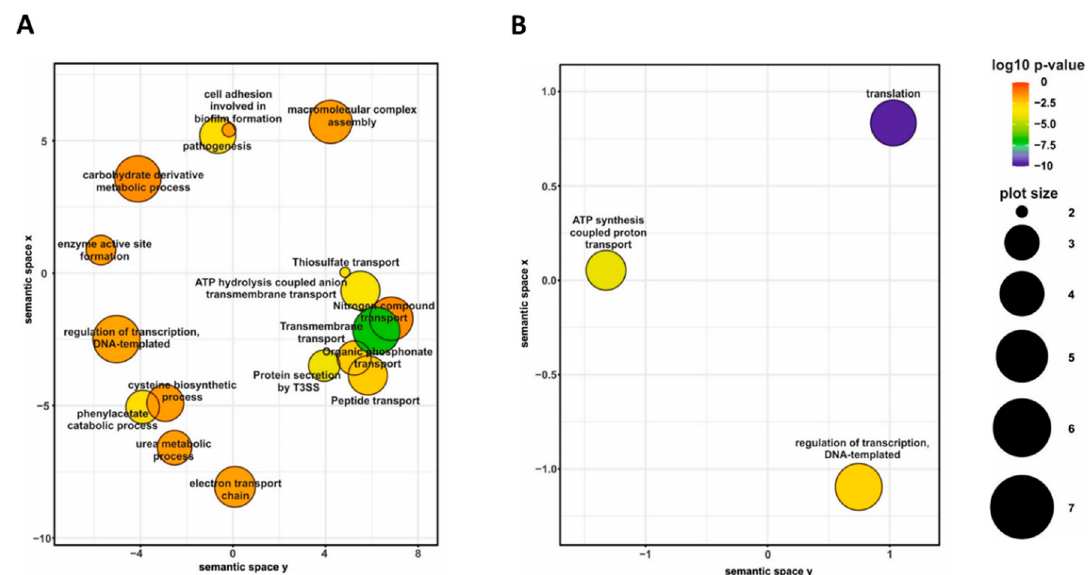
Figure 3. Gene ontology (GO) term enrichment analysis of B. pertussis genes modulated by blood. Significantly enriched GO terms from the domain “biological processes” were identified within gene sets either upregulated ( A ) or downregulated ( B ) in response to direct blood exposure. Results were summarized and visualized by REVIGO as a scatter plot. Circle size depicts the number of genes associated with the respective category; colors encode the significance level of the enrichment.